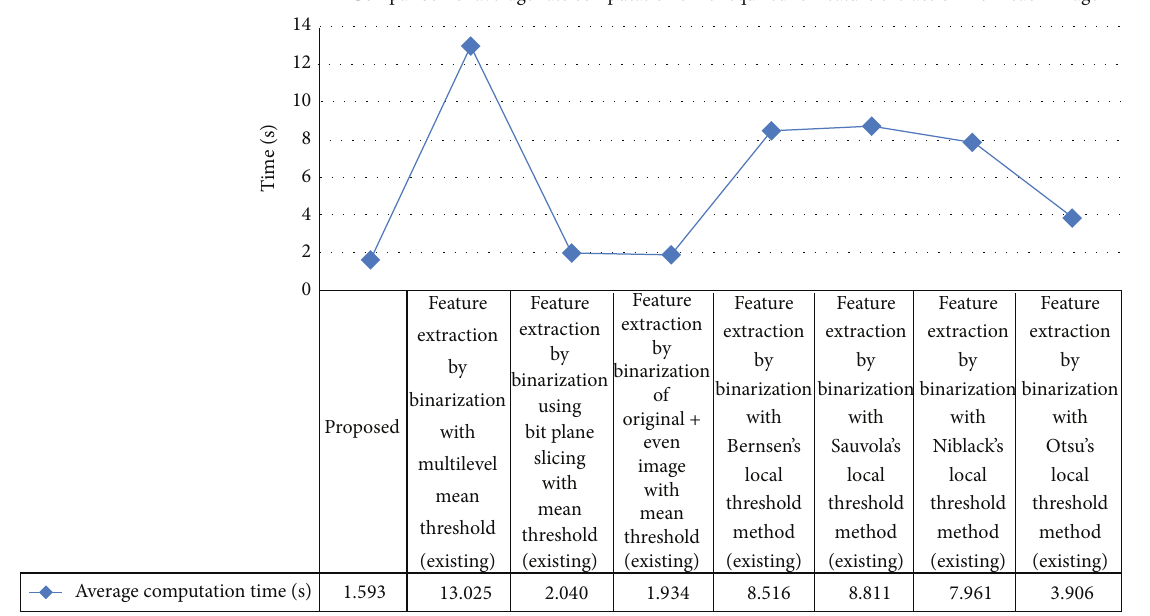
Figure 12: Comparison of averge computation time for feature extraction from each image.